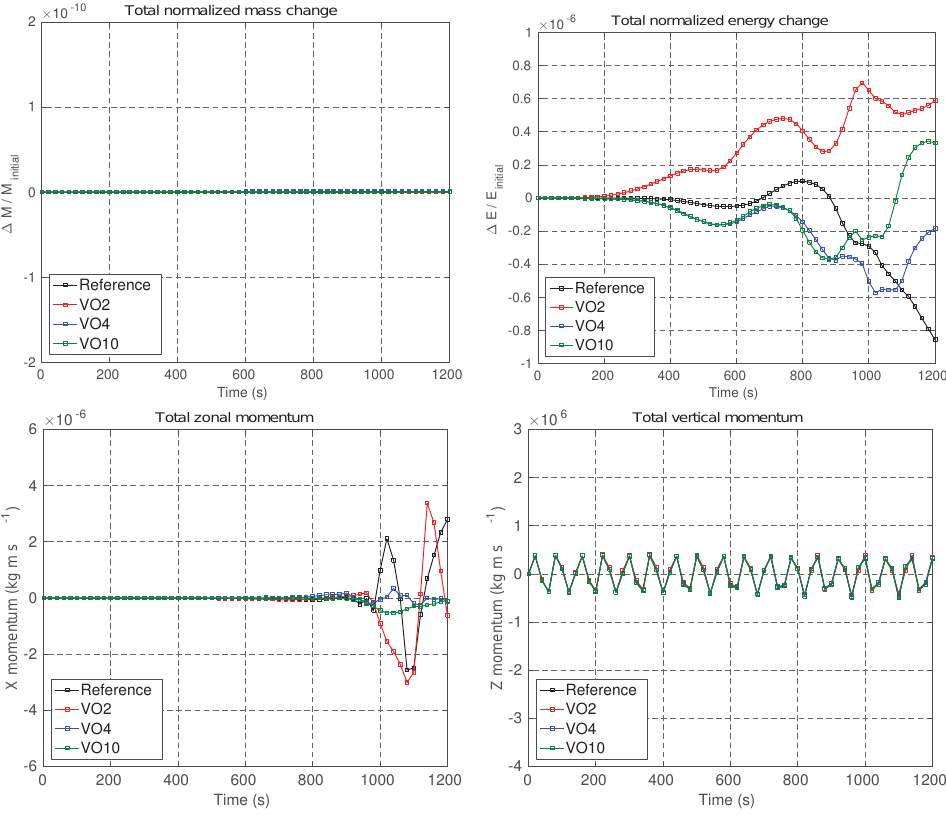
Figure 21. Observed normalized change in mass and energy (top row), along with zonal and vertical momentum (bottom row) using the Robert bubble experiment in Sect. 4.4. The reference solution corresponds to Fig. 17 with 5m resolution. Evaluation experiments use variable vertical order (VO) SNFEM at 10m resolution corresponding to Fig. 19. Total normalized mass and energy change are computed as (Q t − Q initial )/Q initial